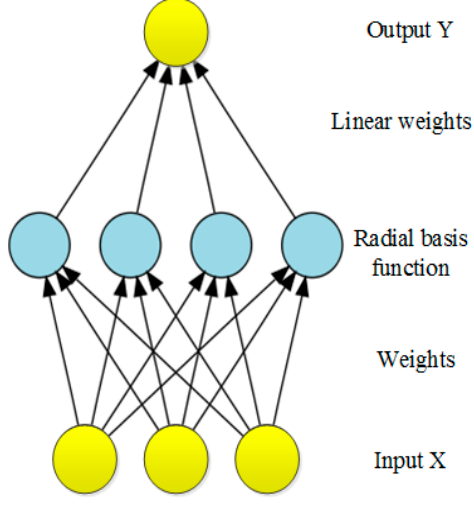
Figure 3. Radial basis function network structure.